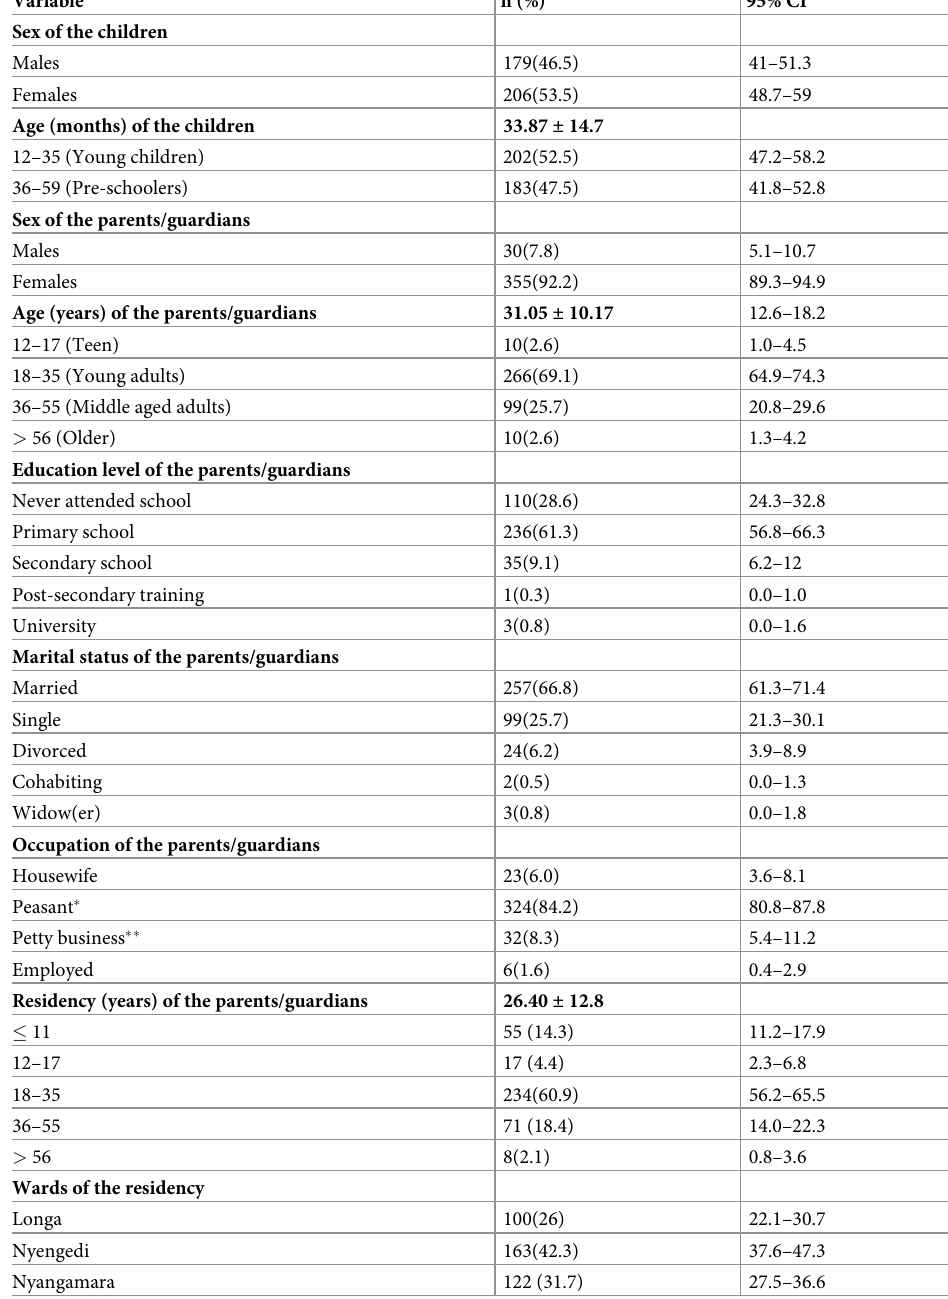
Table 1. Socio-demographic characteristics of the under-fives and their parents/guardians (n =